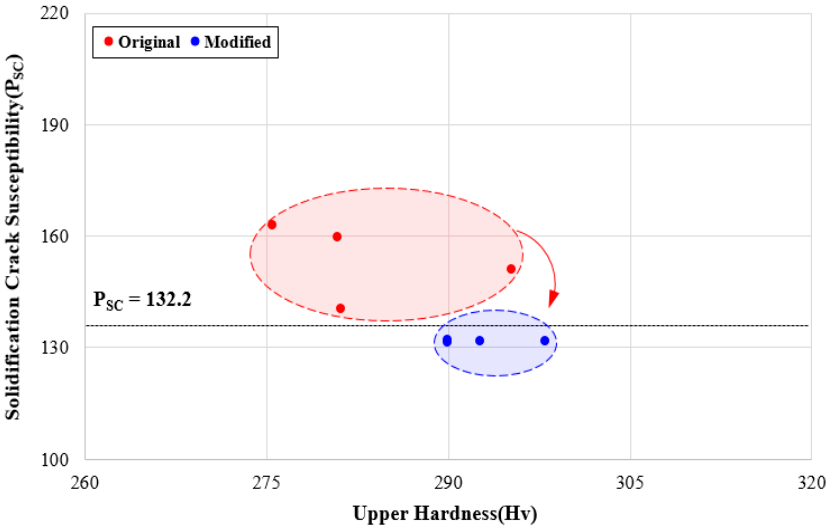
Figure 12. Crack susceptibility distributions using modified input parameters.